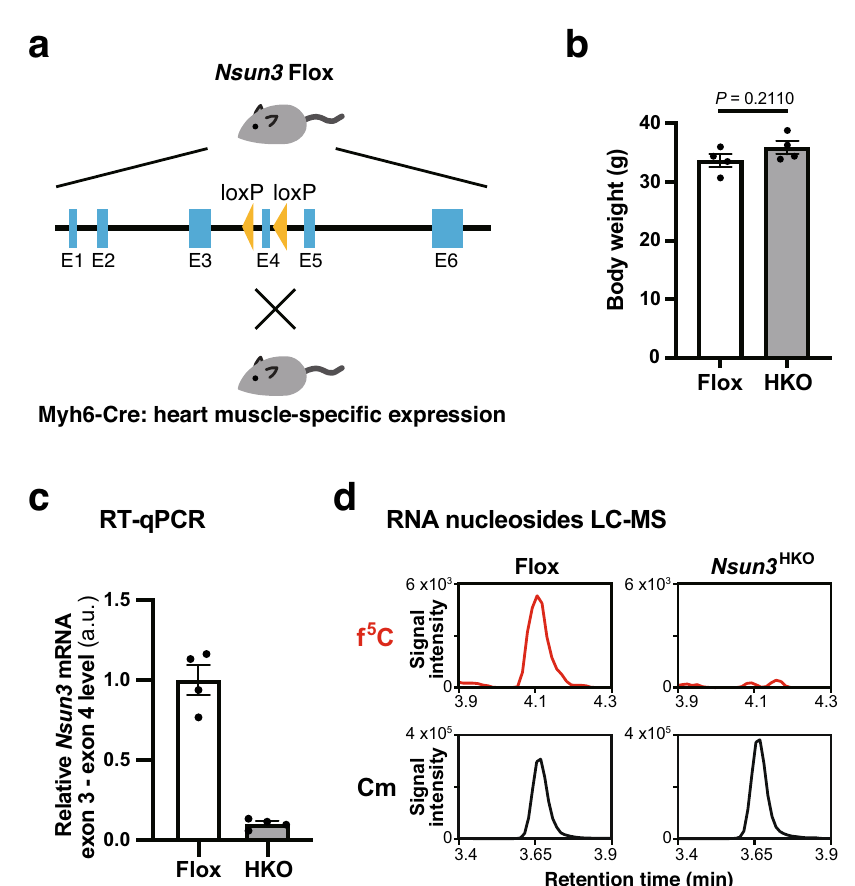
Fig. 2 Generation of heart-speci fi c Nsun3 knockout ( Nsun3 HKO ) mice. a Schematic illustration of the strategy to generate Nsun3 HKO mice. b Body weight of Flox mice and Nsun3 HKO mice at the time of sacri fi ce (13 – 20 weeks). Means ± s.e.m. from n = 4 mice. n.s. not signi fi cant by Welch ’ s t -test. c RT-qPCR of Nsun3 mRNA exon 3 – exon 4 using heart total RNA of 50-week-old Flox mice and Nsun3 HKO mice. The values were normalized by Actb mRNA levels. a.u. arbitrary units. Means ± s.e.m. from n = 4 mice. d LC-MS analysis of total RNA nucleosides made by nuclease P1 digestion of total RNA from mouse heart. Mass chromatograms detecting multiple reaction monitoring of f 5 C (Q1/Q3 = 272.20/140.20) or 2 ′ - O -methylcytidine (Cm, a loading control, Q1/Q3 = 258.25/112.05) are shown. Q1/Q3: the mass of the single-protonated precursor ion and product